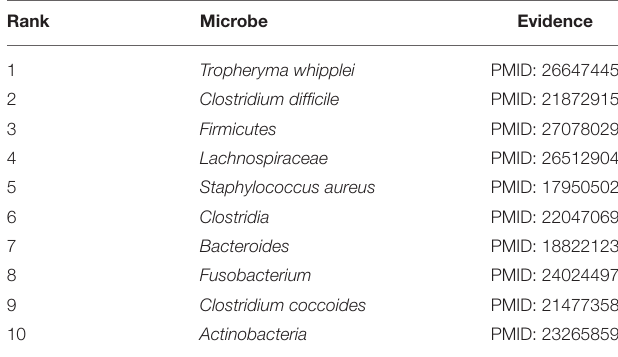
TABLE 2 | AUCs achieved by BWNMHMDA, KATZHMDA, BiRWMP, and LRLSHMDA in LOOCV and 5-Fold CV separately.